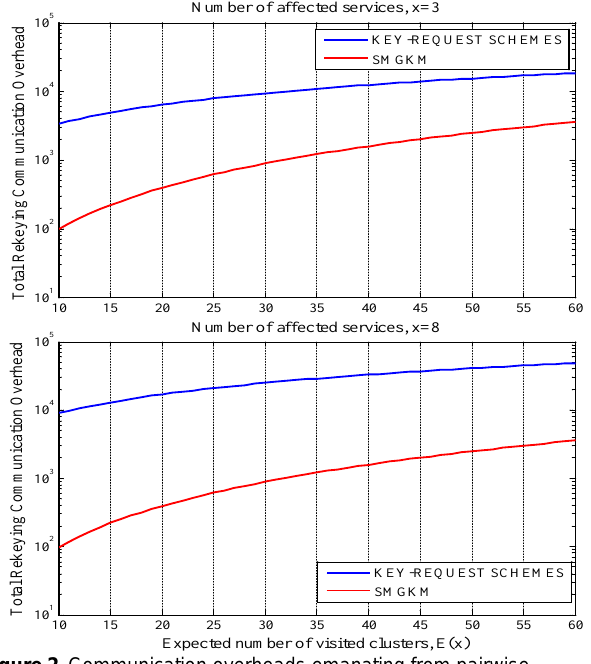
Figure 2. Communication overheads emanating from pairwise rekeying and control messages